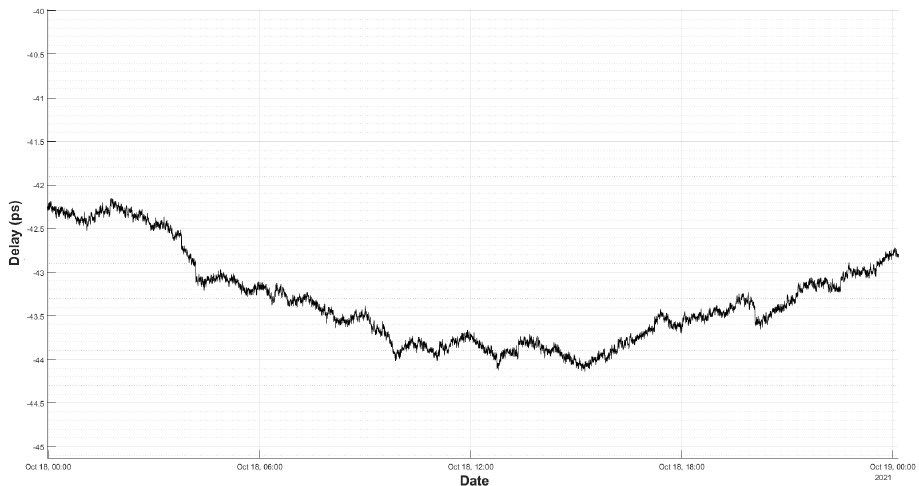
Figure 12. Delay measurement in a thermally stable room for 24 h.